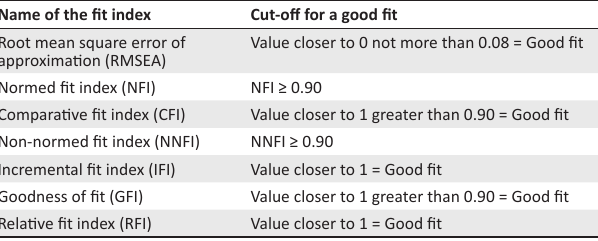
TABLE 2: Structural equation modelling fit